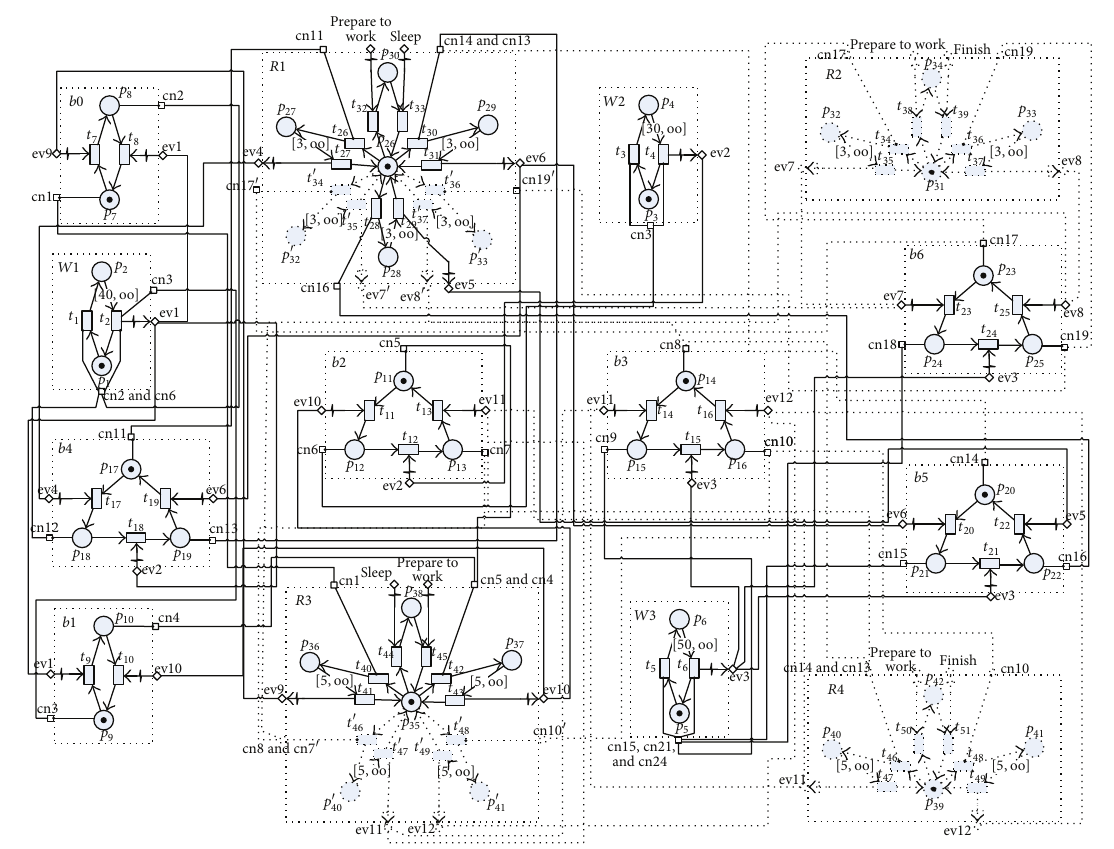
Figure 8: Behavior module of eRN AAS